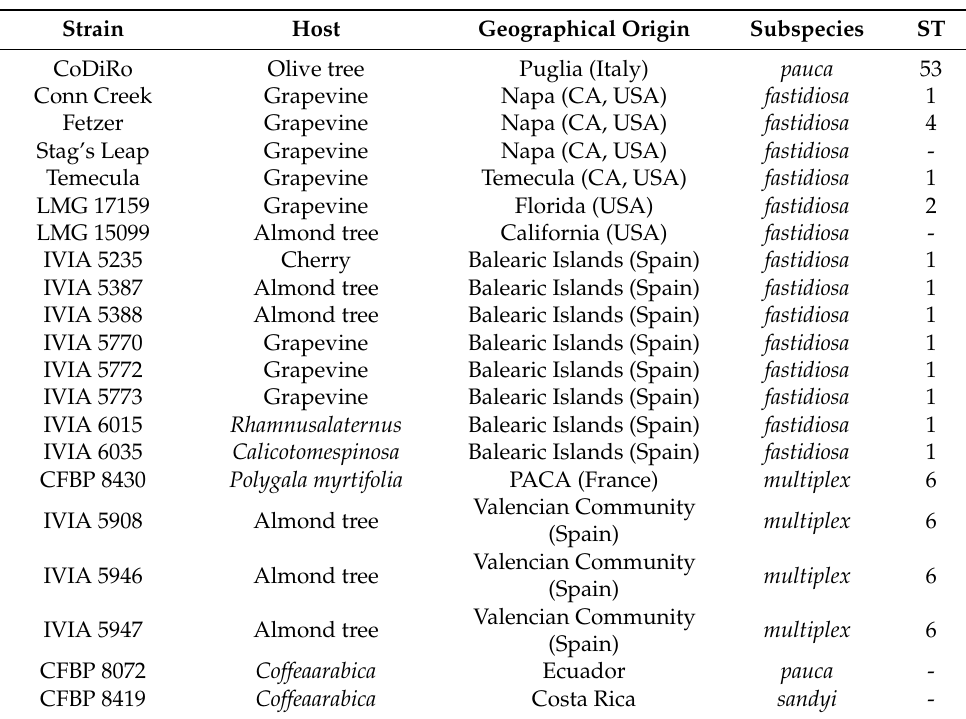
Table 1. Strains of Xylella fastidiosa tested for reactivity with the monoclonal antibody 2G1/PPD and antiserum 17159-O/IVIA.